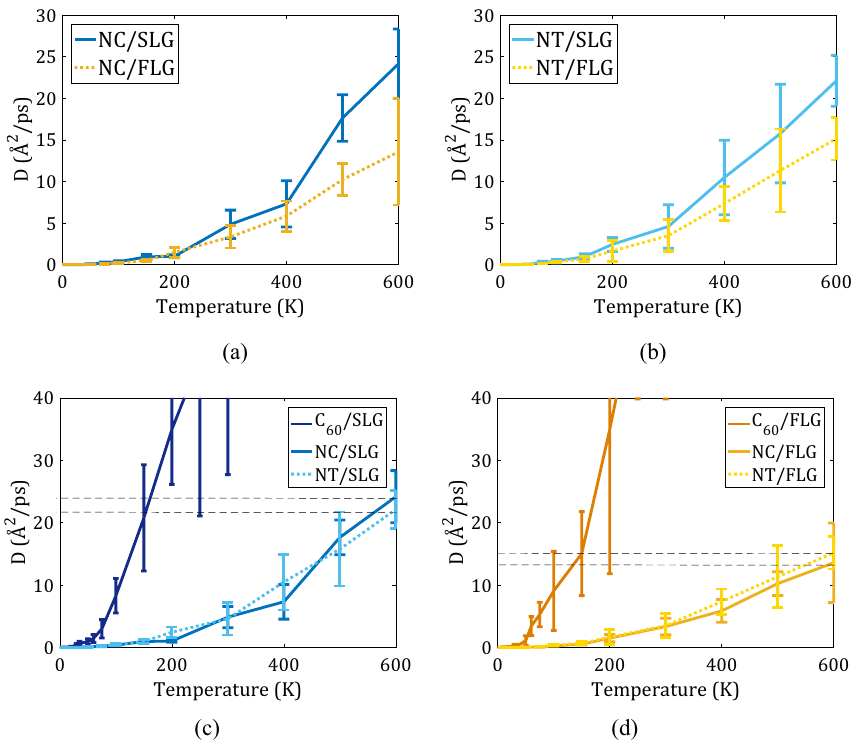
Figure 4. Diffusion coefficient as a function of the temperature diagram of the ( a ) Nanocar and ( b ) Nanotruck mobility on two substrates: (SLG—blue, FLG—yellow). Diffusion coefficient of Nanotruck, Nanocar, and a C 60 wheel on ( c ) SLG, and ( d ) on